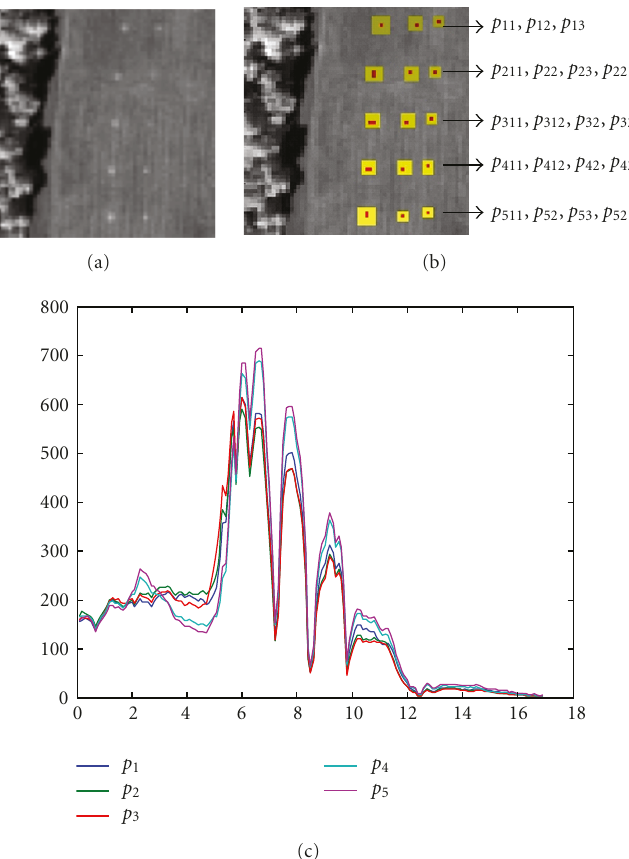
Figure 15: (a) A HYDICE panel scene which contains 15 panels; (b) Ground truth map of spatial locations of the 15 panels; (c) five panel signatures p 1 , p 2 , p 3 , p 4 , p 5